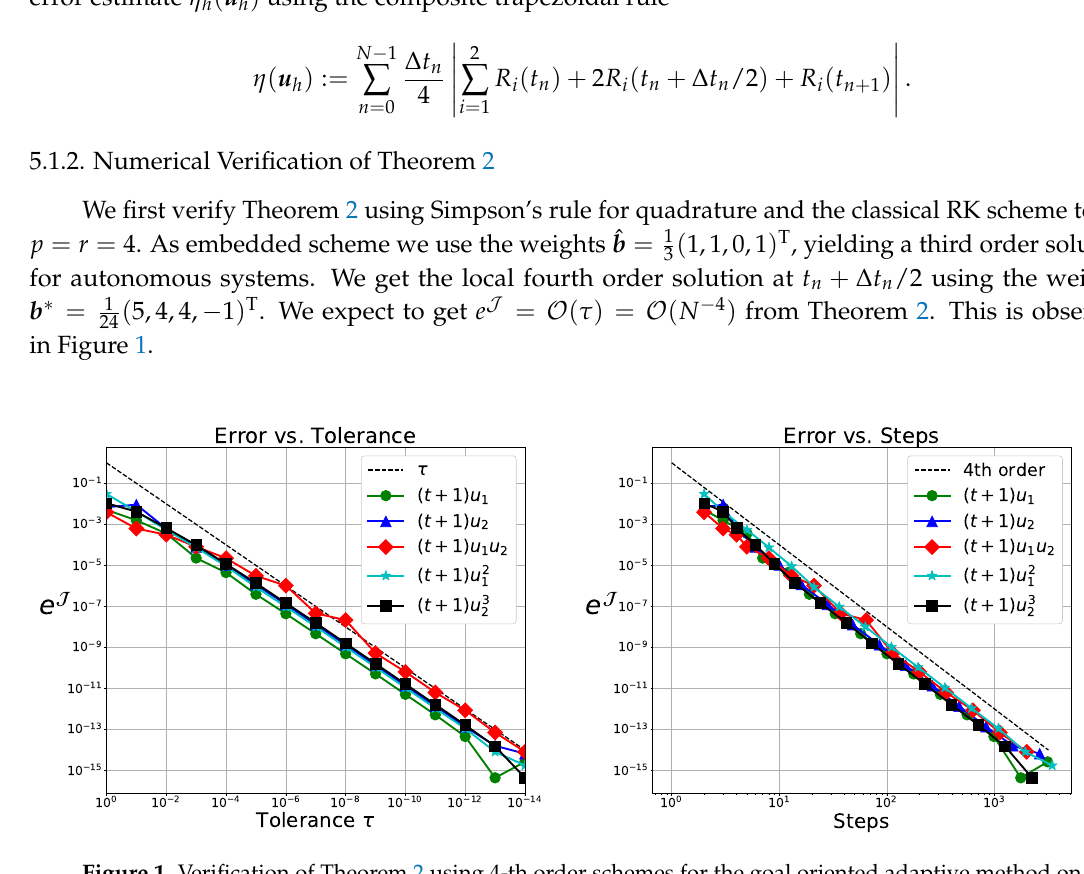
Figure 1. Verification of Theorem 2 using 4-th order schemes for the goal oriented adaptive method on Problem (33) for k = − 1 and functionals j ( t , u ) as shown in the